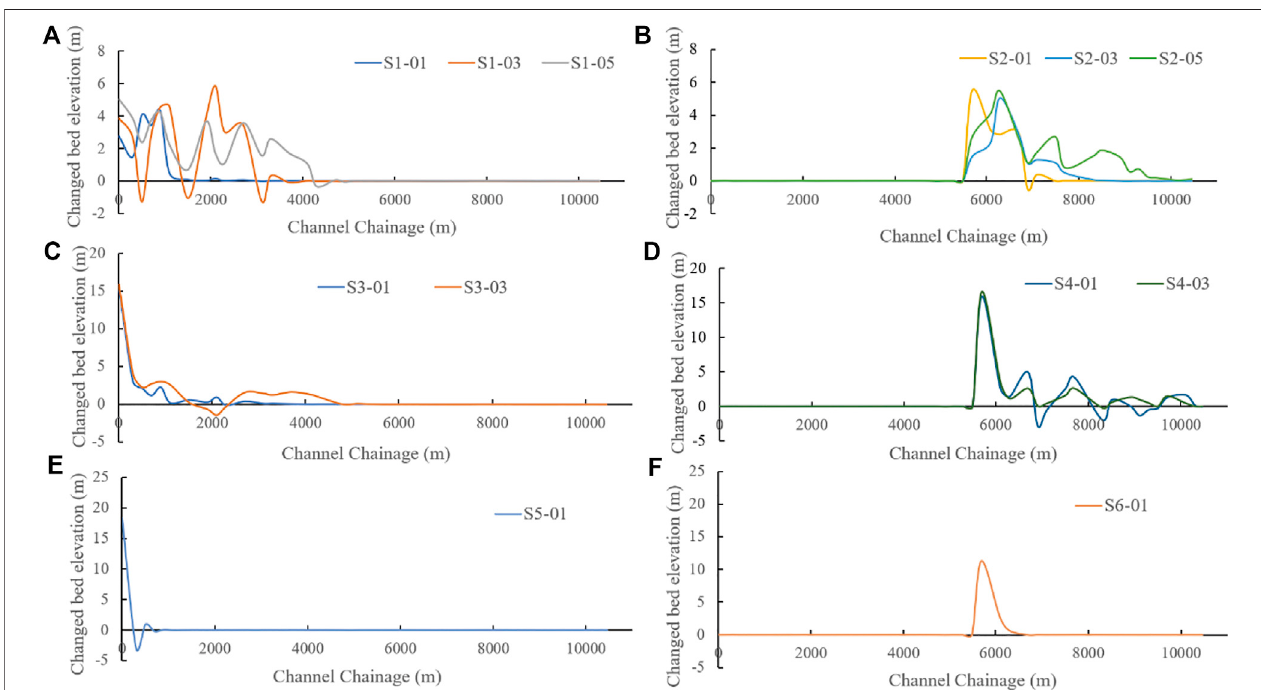
FIGURE 3 | River bed change by different sediment inputcompared to simulation without sediment. (A) , (C) , (E) showed bed change when the in fl ow of sediment was at the beginning point of the reach with medium particle size of (A) 0.06, (C) 1, and (E) 3 mm. (D) , (D) , (F) showed bed change when sediment in fl ow was at Chainage 5,600 m with a medium particle size of (B) 0.06, (D) 1, and (F) 3 mm. Each sub- fi gure contained simulation results of different sediment concentration. When medium particle size of sediment particles increased to 1 mm, the river was clogged by 5% concentration. Therefore, (C) and (D) only showed results of concentration of 1 and 5%. The same results were obtained when medium particle size raised to 3